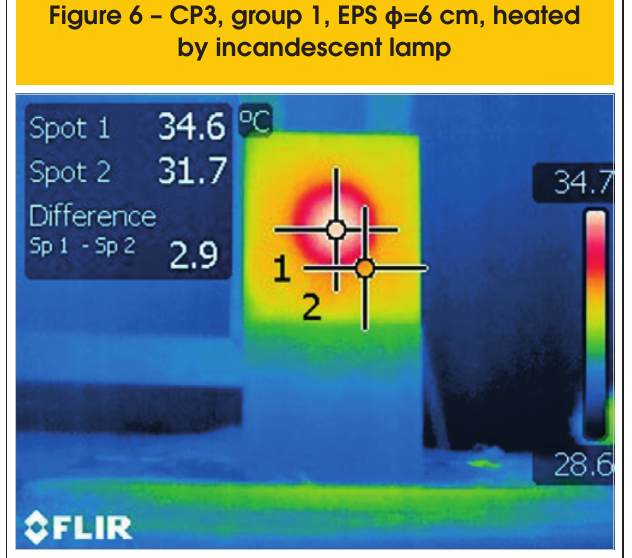
Figure 6 – CP3, group 1, EPS ϕ =6 cm, heated